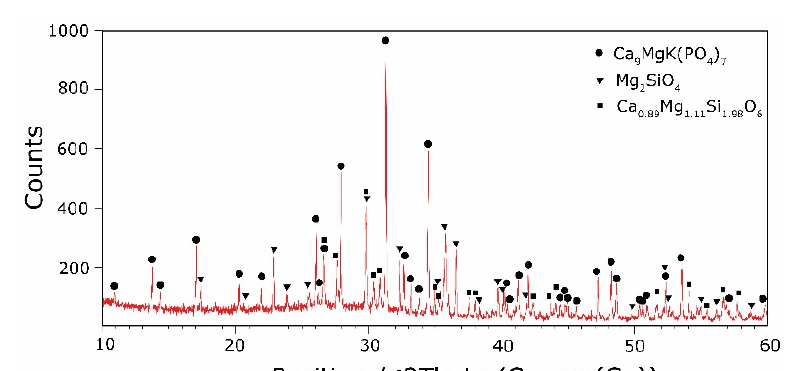
Figure 5. XRD patterns of 2B devitrificate obtained after isothermal heating at 1007 °C (no 2B_1007).